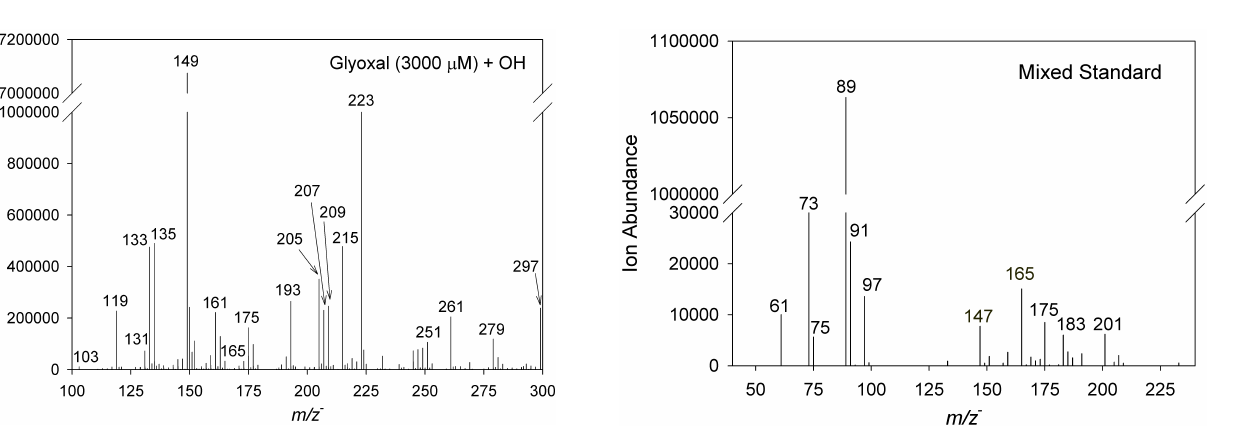
Fig. 5. Negative mode ESI-MS of a mixed standard that contains glyoxal, glycolic acid, glyoxylic acid, oxalic acid, and sulfuric acid. The mass spectrum is in fact a net spectrum obtained by subtracting mixed standard with concentrations of 25µM for all elements from that with